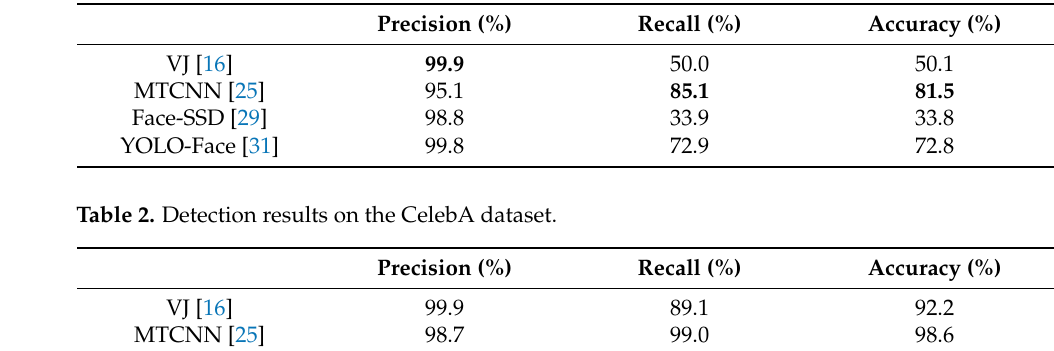
Figure 8. Some face detection result examples. ( Left ) results detected by Face-SSD; ( Middle ) results detected by MTCNN; ( Right ) results detected by YOLO-Face. The predicted location and the ground truth are in red and blue, respectively. Table 1. Detection results on the FDDB dataset.